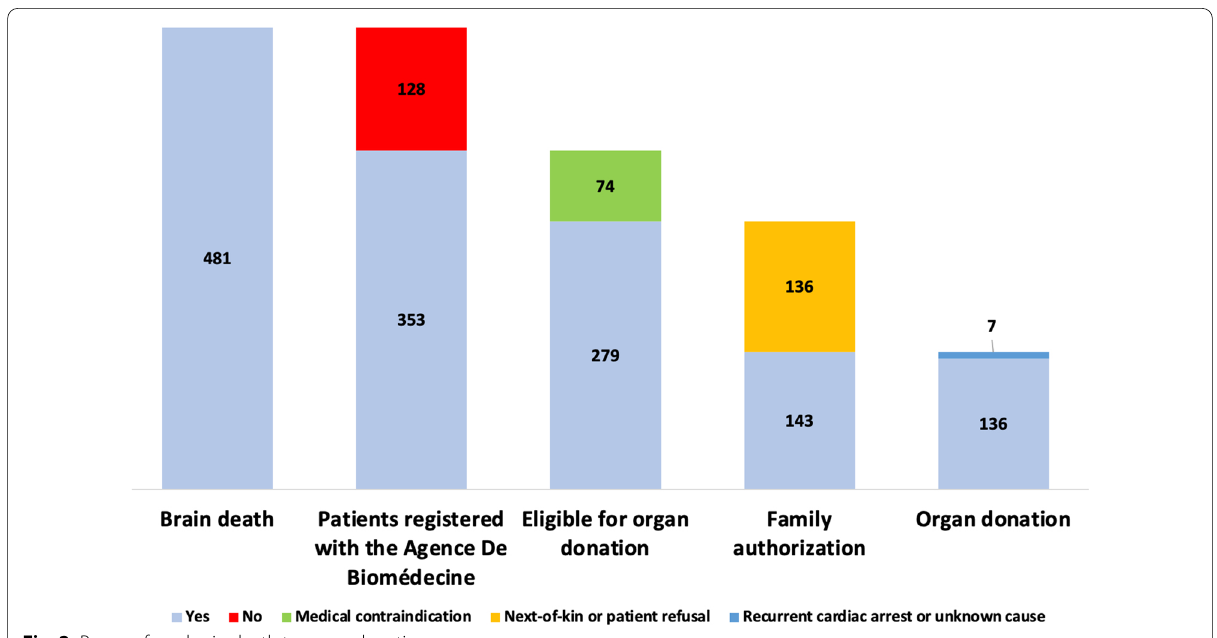
Fig. 2 Process from brain death to organ donation